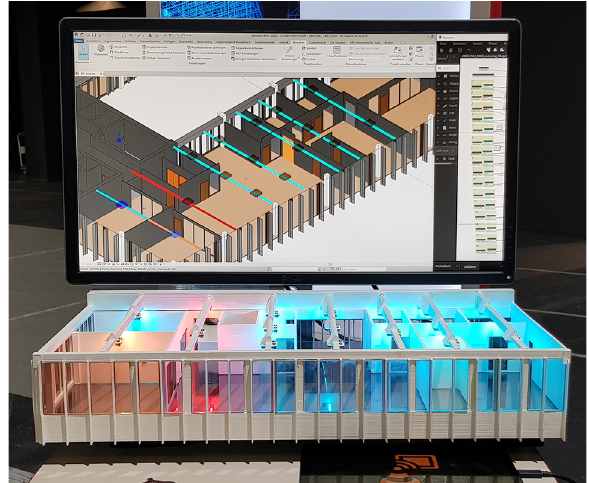
Figure 11. Prototype created to investigate the interactivity through IoT between a physical model containing sensors and its digital twin. Below: 3D printed model of part of the campus, and on the screen, the building information model with